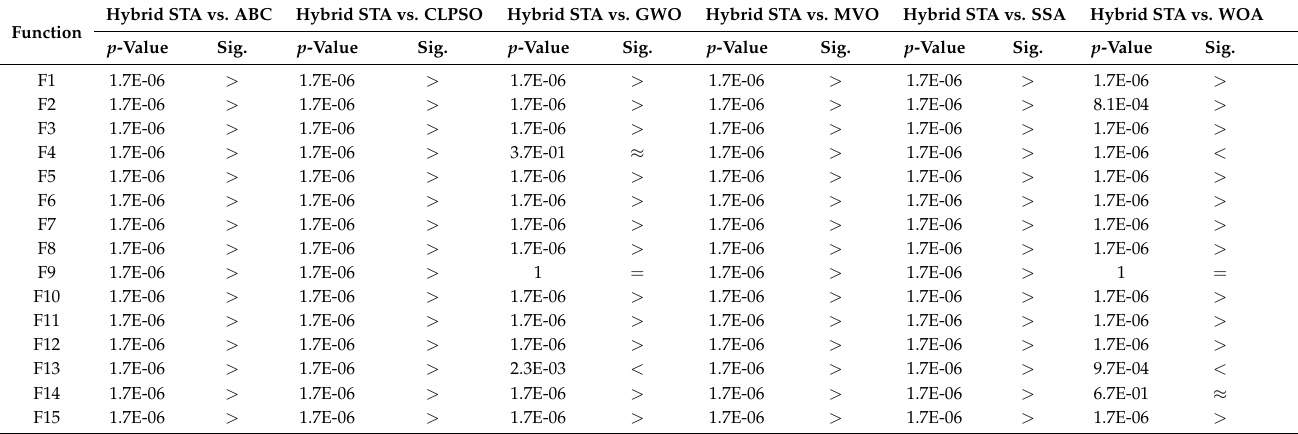
Table 12. Wilcoxon signed-rank test in 100